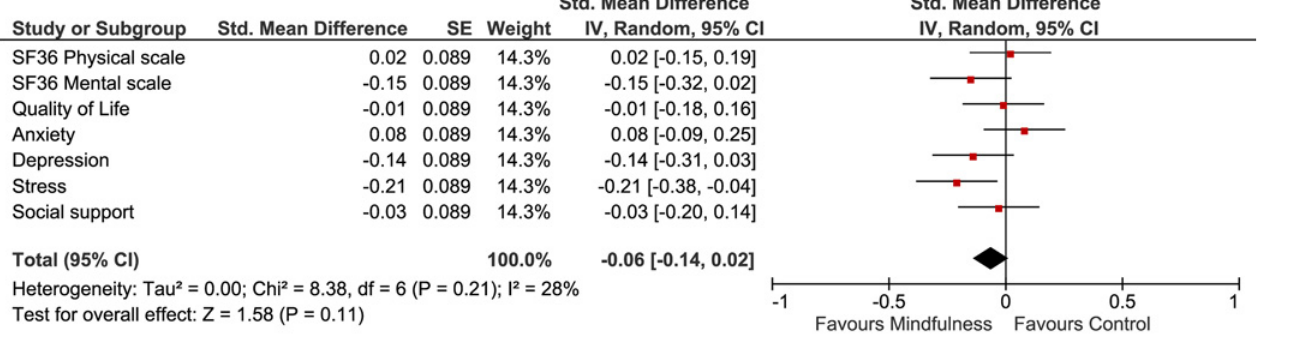
S1 Table. Content web-based mindfulness training. (DOCX)